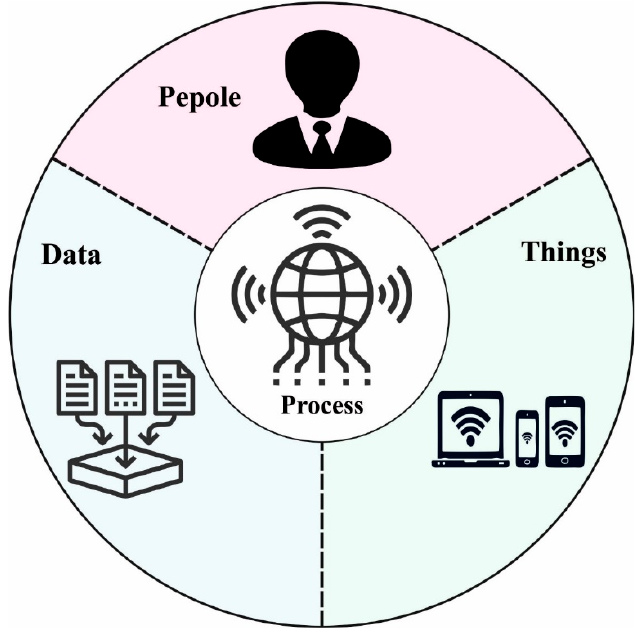
Figure 1. Representation of